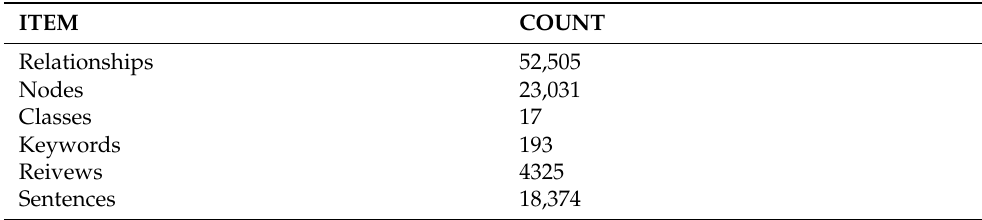
Table 2. Graph database